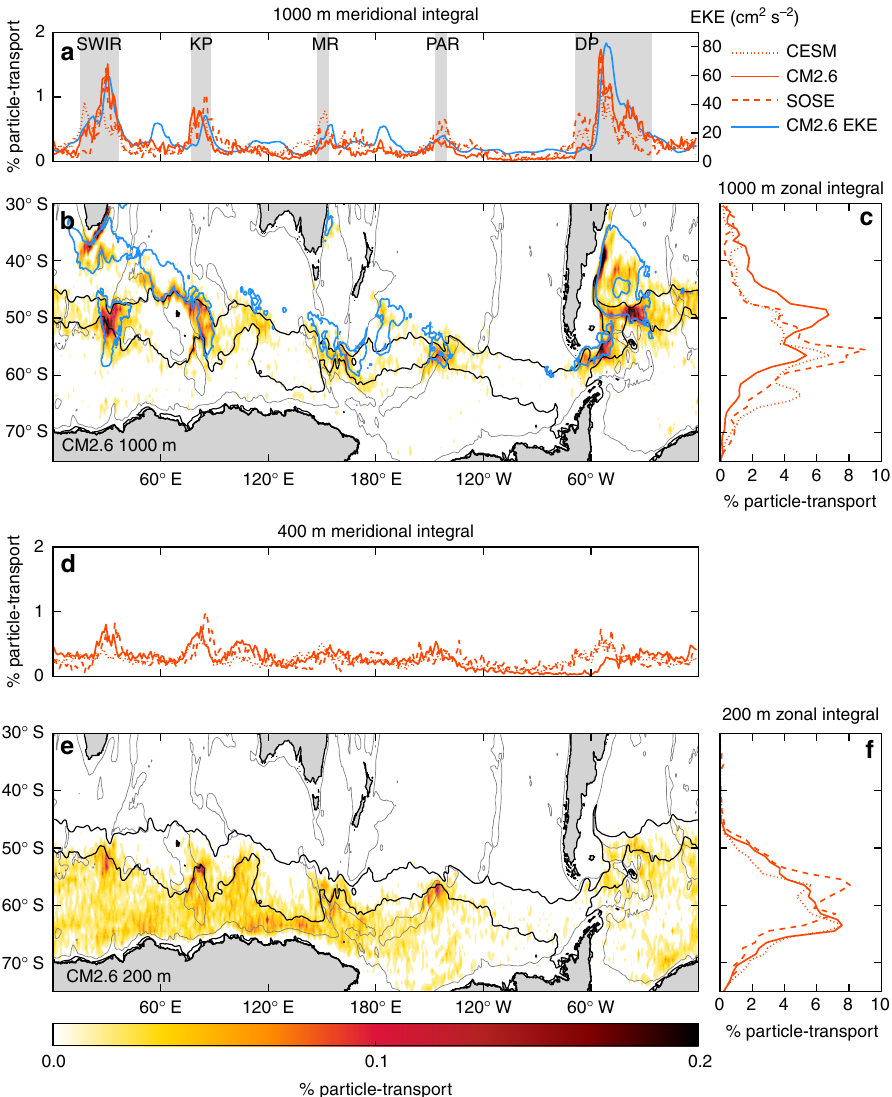
Fig. 6 Upwelling of particles across depth horizons. a Percent of total upwelling particle transport crossing 1000m (1000m is chosen because it is representative of upwelling in the interior and lies above major topographic features) as a function of longitude, integrated across all latitudes for all three models; the blue line shows the mean eddy kinetic energy (EKE) at 1000m in CM2.6 averaged between 30° S and Antarctica at each longitude; gray shaded bars show the location of the fi ve major topographic upwelling hotspots: the Southwest Indian Ridge (SWIR), Kerguelen Plateau (KP), Macquarie Ridge (MR), Paci fi c – Antarctic Ridge (PAR), and Drake Passage (DP). b Percent of particle transport crossing 1000m in each 1° latitude×1° longitude grid box between release at 30° S and the mixed layer in CM2.6. Blue contours indicate regions where the mean EKE at 1000m in CM2.6 is higher than 75 cm 2 s − 2 . c Percent of particle transport crossing 1000m depth as a function of latitude, integrated across all longitudes for all three models. d Same as a for 200m, without EKE contours, e same as b for 200m without EKE contours, and f same as c for 200m. In all panels, we select the location at which particles cross depth surfaces for the fi nal time along their trajectories. Qualitatively similar results are obtained from selecting fi rst-crossing locations. Black contours in b and e are the outermost closed contours through Drake Passage of mean sea surface height in CM2.6, representing the path of the Antarctic Circumpolar